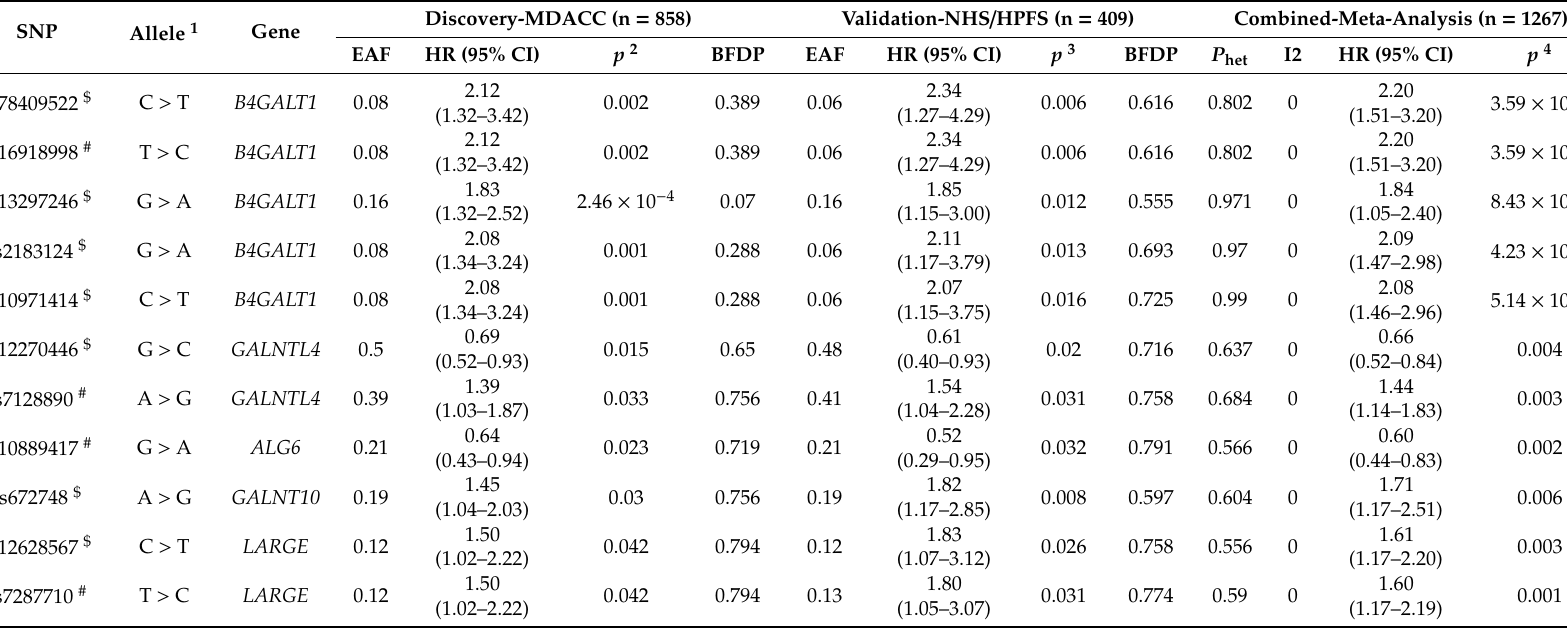
Table 1. Meta-analysis of 11 validated SNPs in the glycosylation pathway genes using two independently published melanoma genome-wide association study (GWAS)